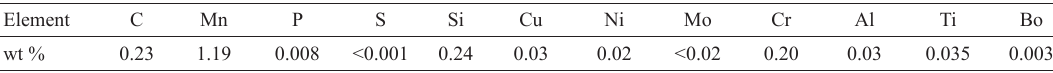
Table 1: Chemical composition of 22MnB5 steel (source: Arcelor Mittal). Element